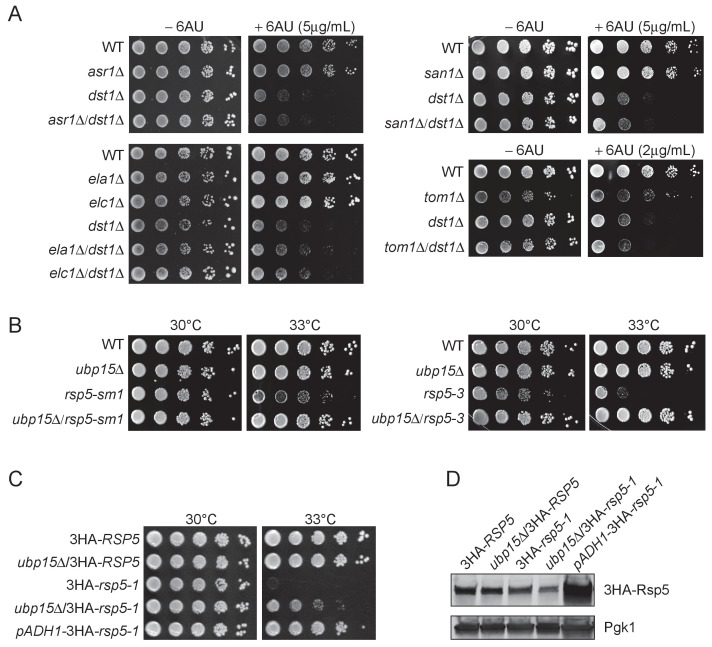
A screen for E3 ligases genetically connected to UBP15.(A) Serial-dilution growth assays to screen various E3 ligases for genetic interaction with DST1. The indicated yeast strains were grown to saturation in YNB lacking uracil (−URA), washed, resuspended at the same density in water, serially diluted (fivefold series), and spotted on −URA in the absence or presence of 6AU as indicated. Plates were incubated for 3 days at 30°C. (B) Serial-dilution growth assays assessing the effect of UBP15 deletion on the viability of rsp5-1, rsp5-sm1, and rsp5-3 cells at 33°C or 37°C. The indicated yeast strains were grown to saturation in YPD, washed, resuspended at the same density in water, serially diluted (fivefold series), and spotted on YPD. Plates were incubated for 3 days at 30°C or 33°C as indicated. (C) Serial-dilution growth assays assessing the effect of Rsp5-1 overexpression (when expressed under the ADH1 promoter) on the viability of rsp5-1 cells at 33°C. The indicated yeast strains were grown to saturation in YPD, washed, resuspended at the same density in water, serially diluted (fivefold series), and spotted on YPD. Plates were incubated for 3 days at 30°C or 33°C as indicated. (D) Western blot showing HA-Rsp5 levels in WT, rsp5-1, ubp15Δ, and ubp15Δ/rsp5-1 cells. The expression of Rsp5-1 under the control of the ADH1 promoter (used in ‘C’) is also shown.